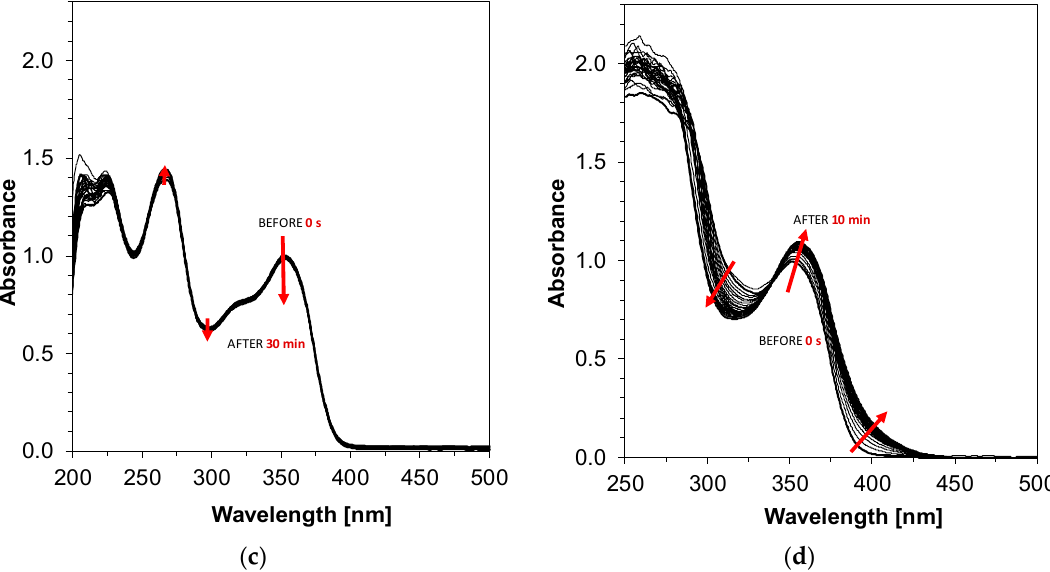
Figure 3. Steady-state photolysis of: ( a ) S4 in acetonitrile under 365 nm (126 mW/cm 2 ) for 30 min; ( b ) S4 with iodonium salt (HIP—diphenyliodonium hexafluorophosphate) in acetonitrile under 365nm (126mW/cm 2 ) for 10 min; ( c ) S4 in acetonitrile under 405 nm (455 mW/cm 2 ) for 30 min; ( d ) S4 with iodonium salt (HIP) in acetonitrile under 405 nm (455 mW/cm 2 ) for 10 min.